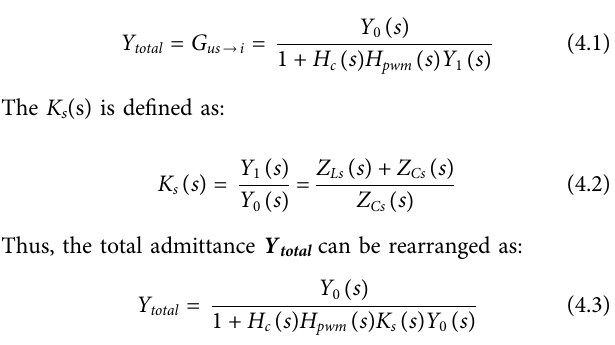
Frontiers in Energy Research |